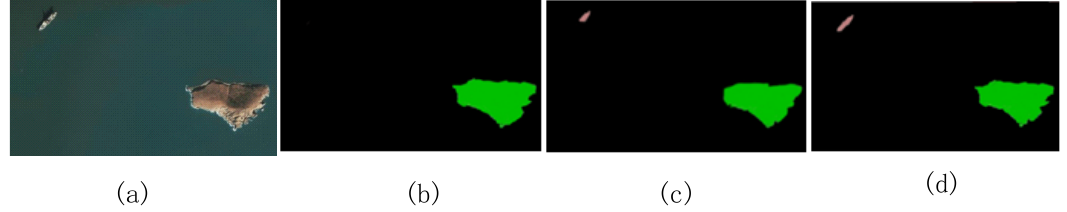
Figure 9. Semantic segmentation of ships with an island ( a ) Original ( b )CRF-RNN ( c ) DeepLab ( d ) Proposed model